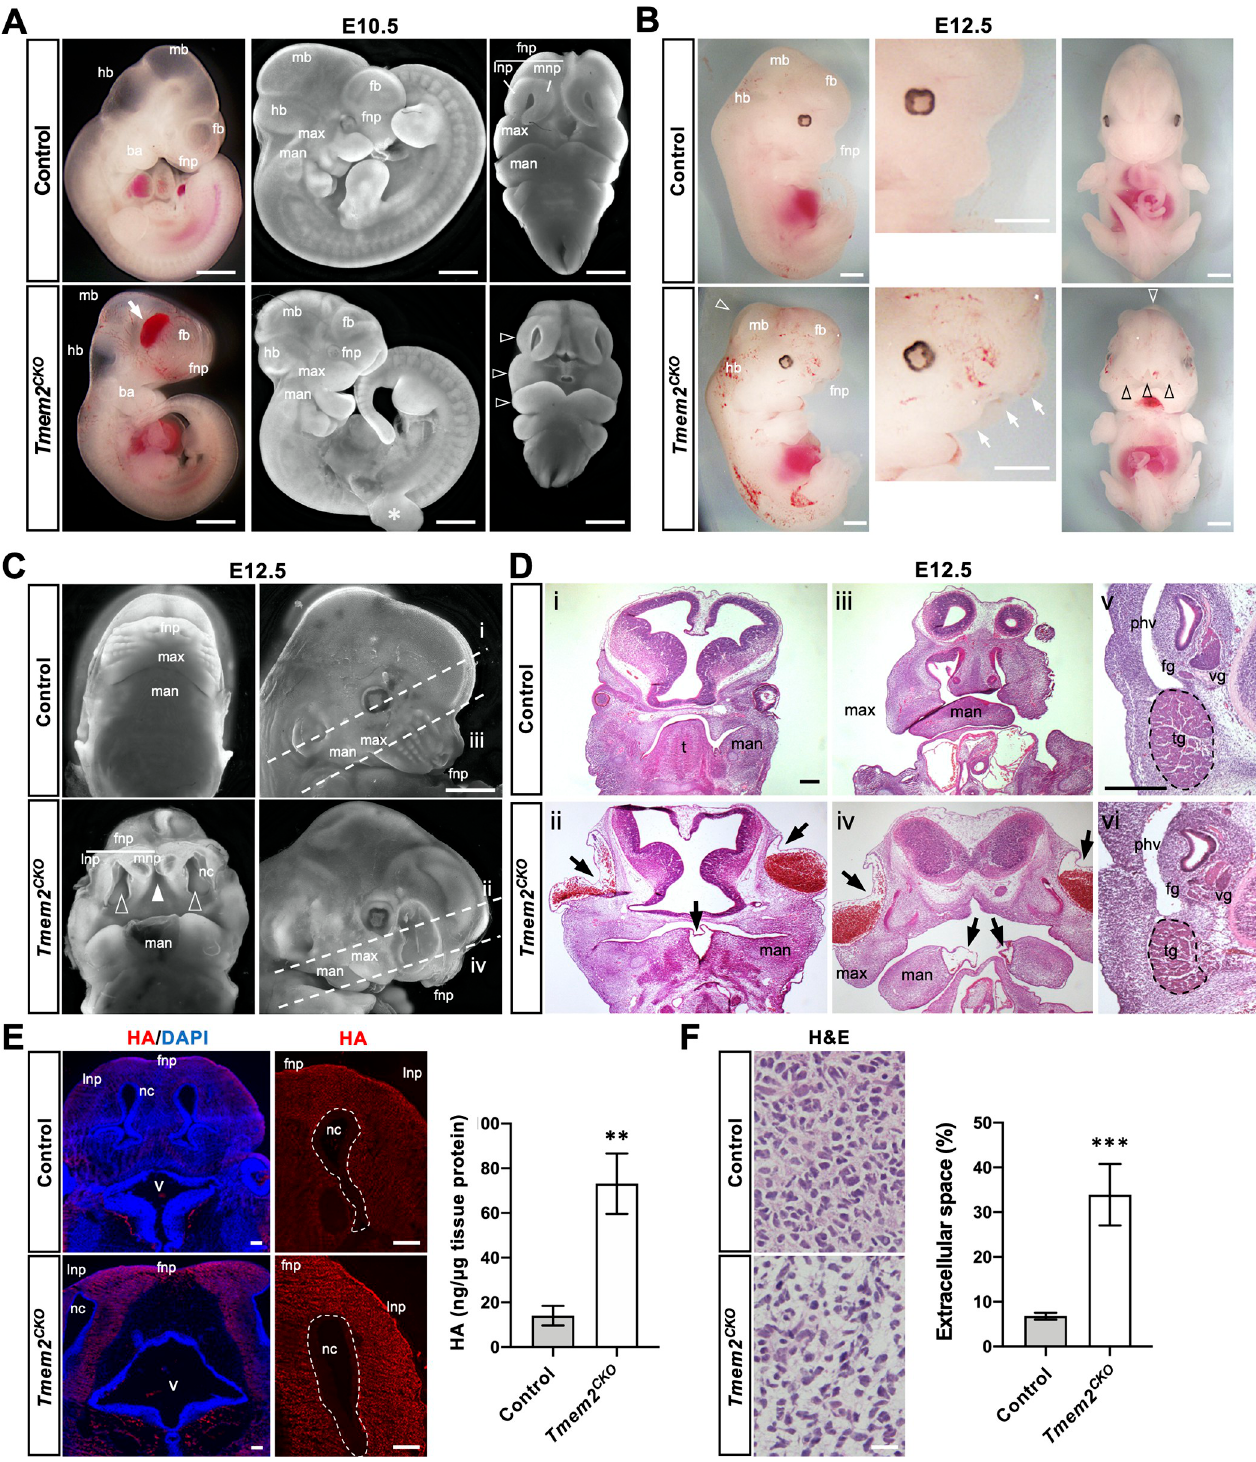
Fig 1. NCC-targeted conditional knockout of Tmem2 leads to craniofacial malformations. ( A ) Gross phenotype of Tmem2 CKO embryos at E10.5. Whole- mount images of unstained embryos ( left panels ) and fluorescence microscopic images of DAPI-stained embryos ( center and right panels ) are shown. Hypoplasia of the frontonasal process, maxillary process, and mandibular process is observed in Tmem2 CKO ( open arrowheads ). Arrow indicates edema in the facial region. Asterisk indicates a partial tear of the right forelimb bud inadvertently caused during dissection. ( B ) Gross phenotype of Tmem2 CKO embryos at E12.5. Whole-mount images reveal severe developmental malformations of the craniofacial region of Tmem2 CKO embryos, with marked hypoplasia of the facial